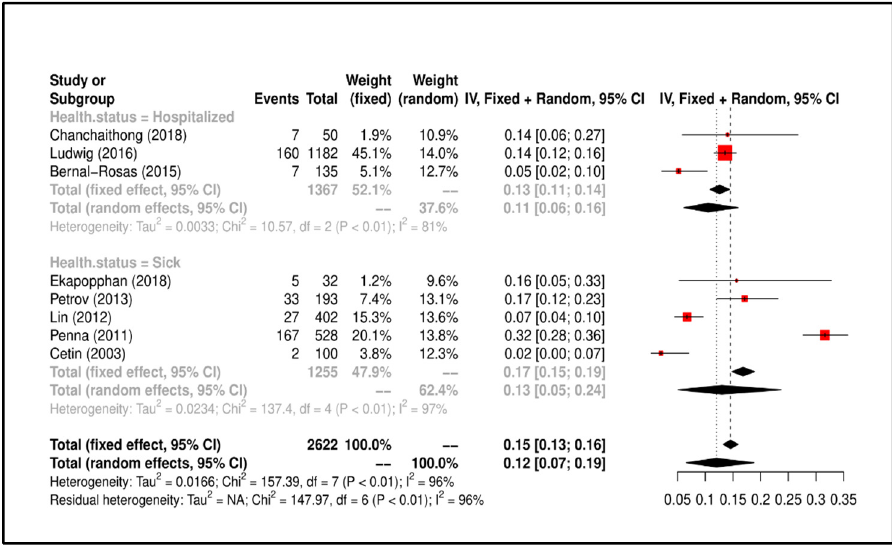
Figure 6. Forrest plot corresponding to occurrences of P. aeruginosa grouped by “health status of dog”.